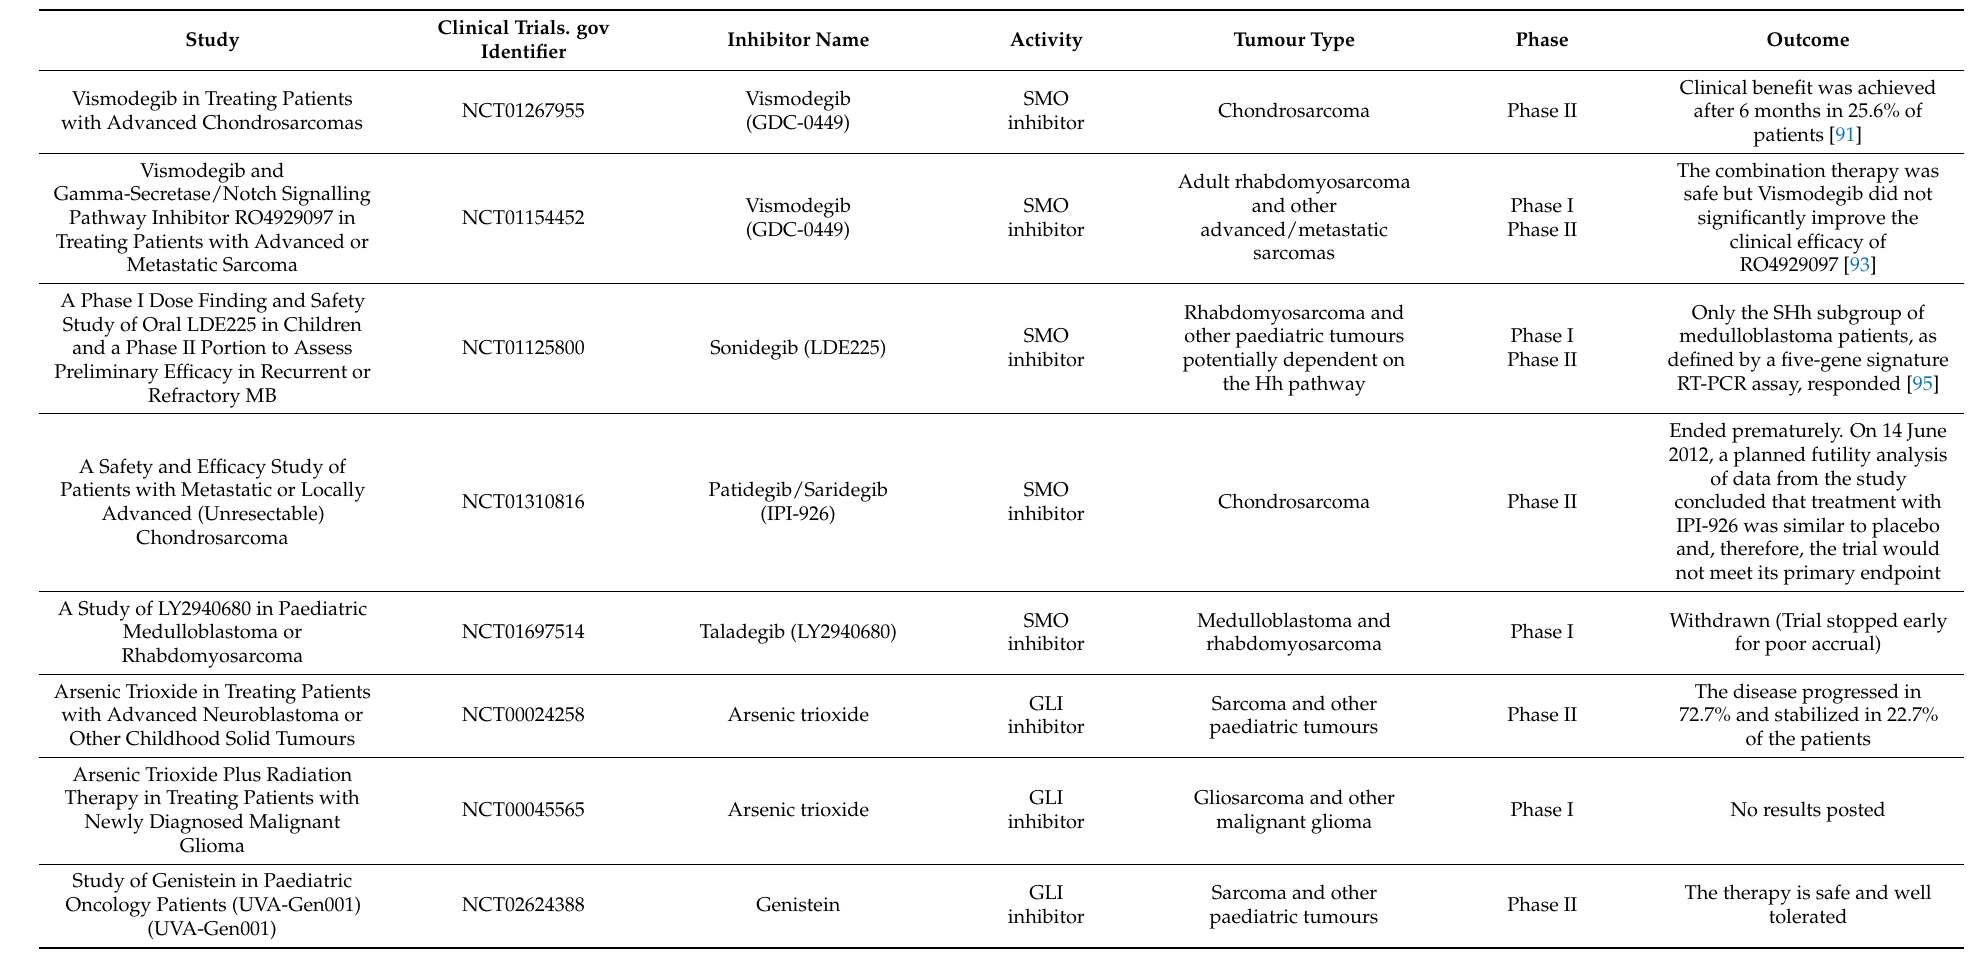
Table 1. Clinical trials with Hh pathway inhibitors in